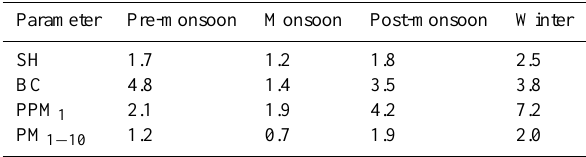
Table 2. Diurnal cycle amplitudes of the typical day in different seasons for specific humidity (SH), black carbon (BC), PM 1 and PM 1 − 10 . Amplitudes are expressed as the ratio between the highest and the lowest 30-min averaged